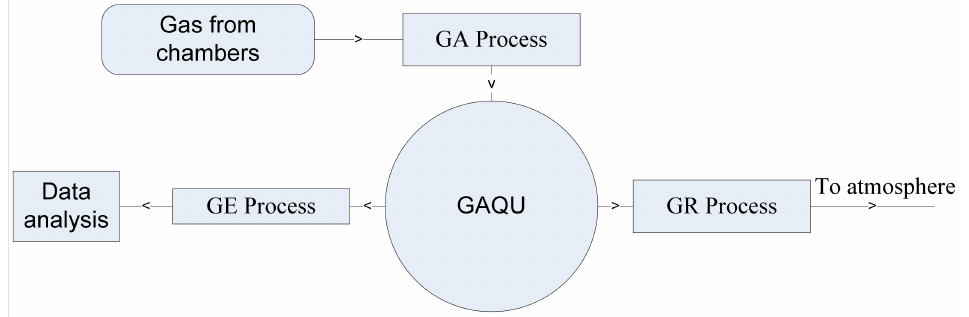
Figure 6. Three processes utilized for GHG estimation.